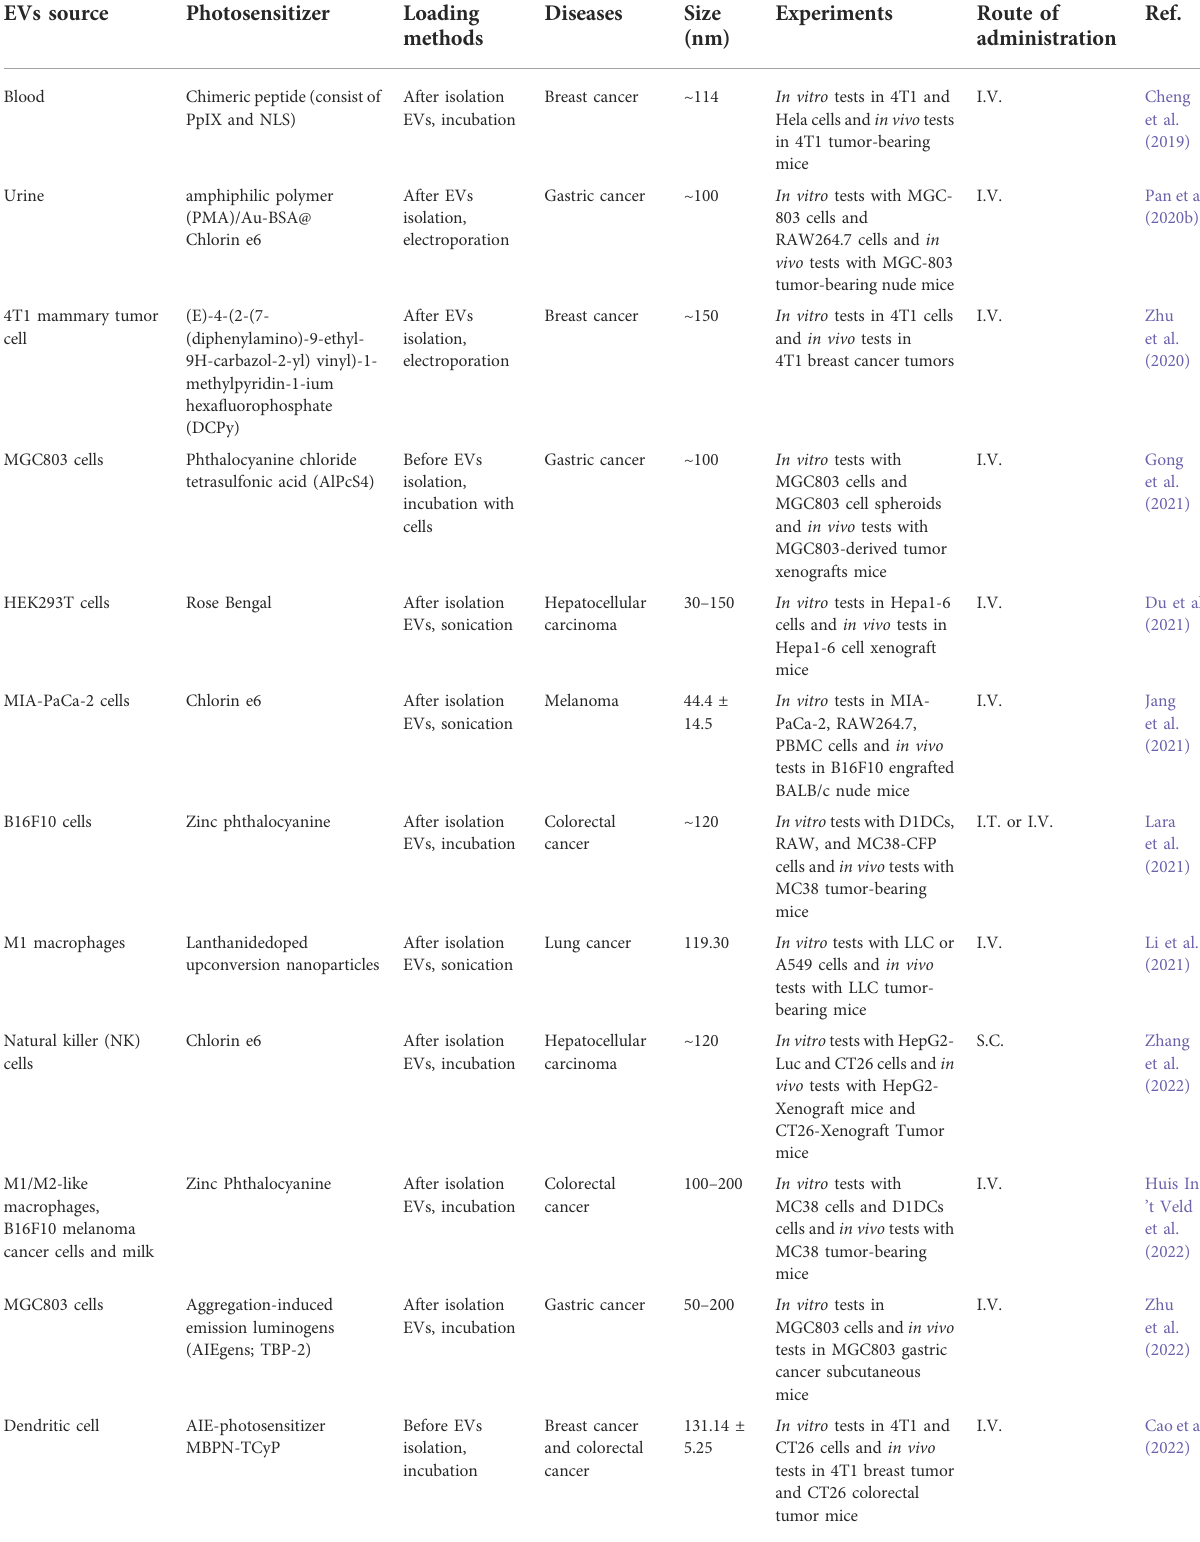
TABLE 4 Preclinical studies on photosensitizer-loaded EVs for PDT